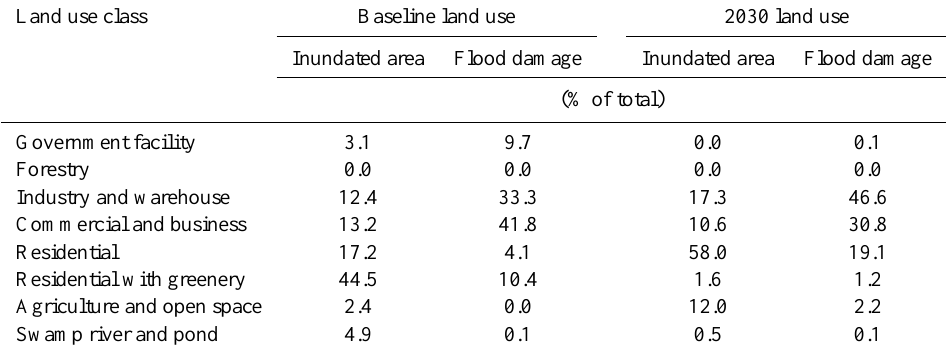
Table 6. Percentage of total inundated area and total flood risk found in each land use category. Results are shown here for baseline land use and idealized land use in